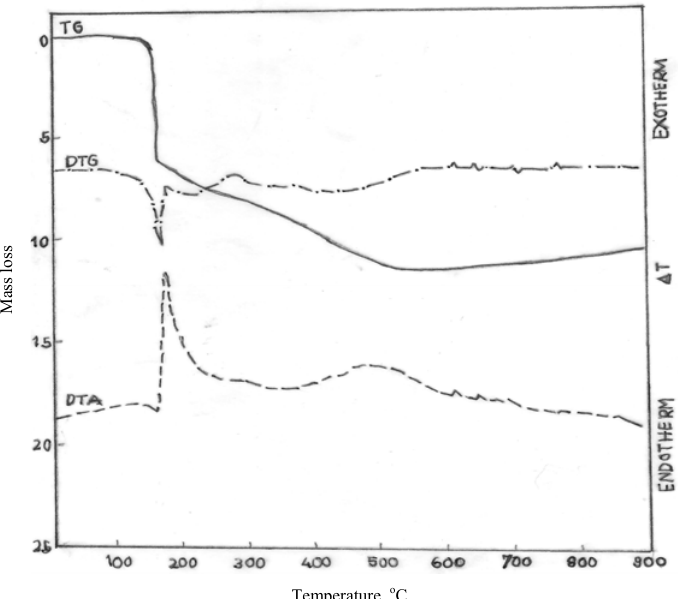
(C H NO P ) 4.H O (200 mg 5 3 4 8 2 2 2